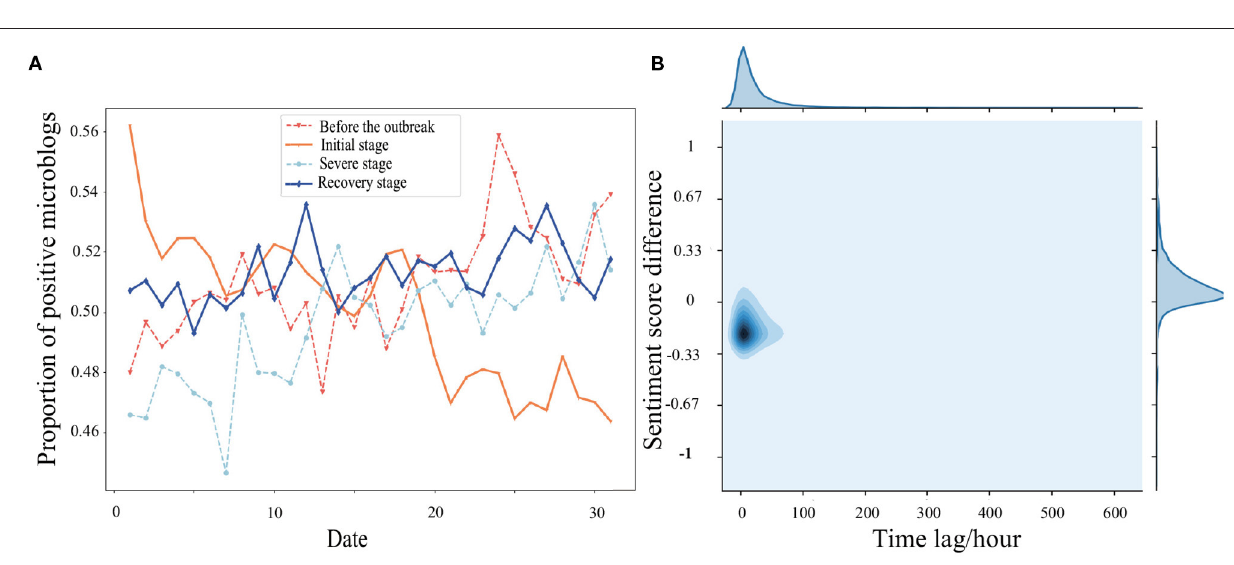
FIGURE 7 | (A) Proportion of positive microblogs in four stages and (B) correlation KDE map of sentiment score difference and time lag. The x-axis expresses the date of each stage chronologically, for example, for the severe stage it is from February 1, 2020 to March 2,